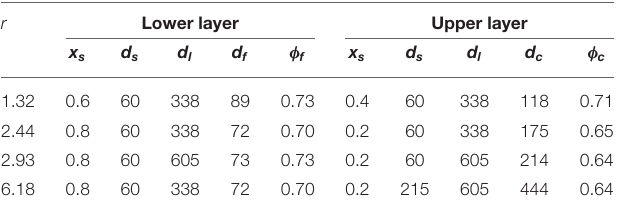
TABLE 2 | Particles used for two-layer beds where each layer is a mixture of particles. r Lower layer Upper